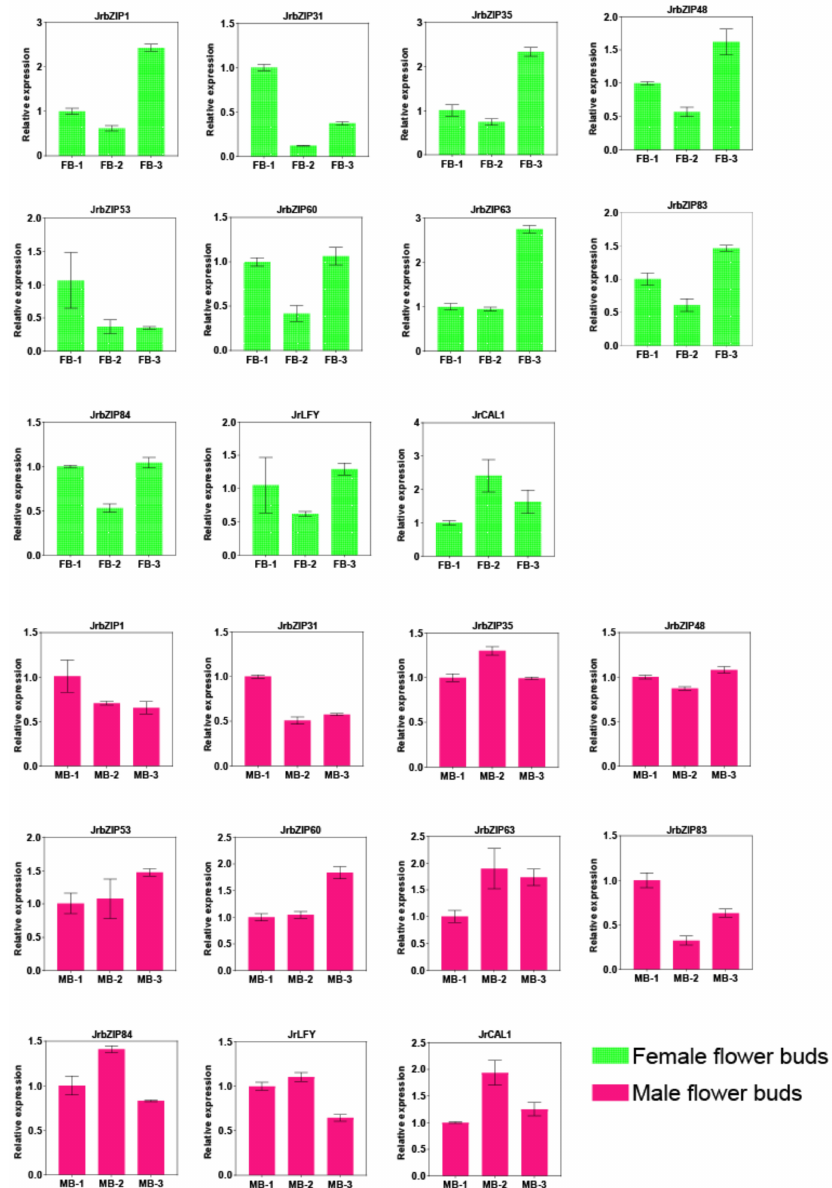
Figure 9. qRT-PCR analysis of JrbZIP genes in different tissues and development periods of flower buds. FB-1, FB-2, FB-3, MB-1, MB-2, and MB-3 represent the different developmental periods in female (green bar chart) and male (red bar chart) flower buds,